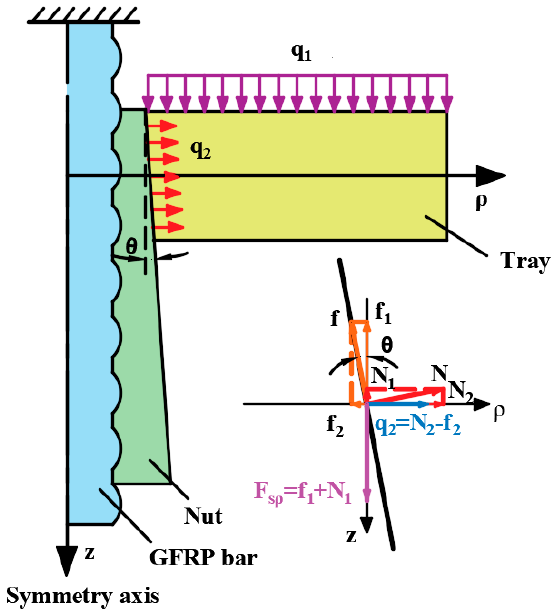
Figure 8. Theoretical calculation model of tray.